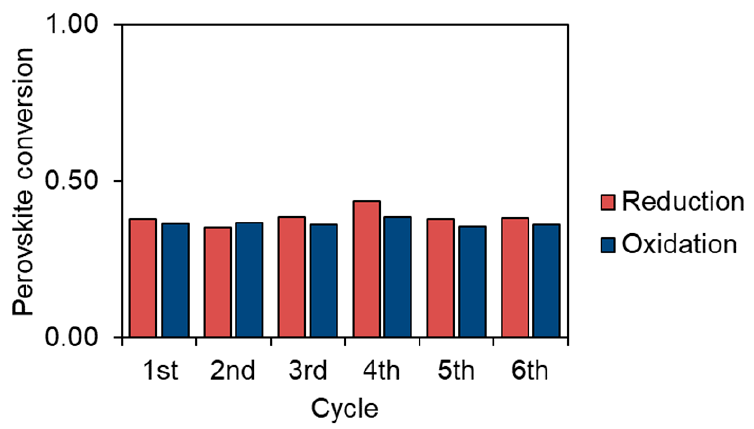
Figure 8. Conversion degree during reduction/oxidation isothermal cycles at 920 °C with H 2 O.